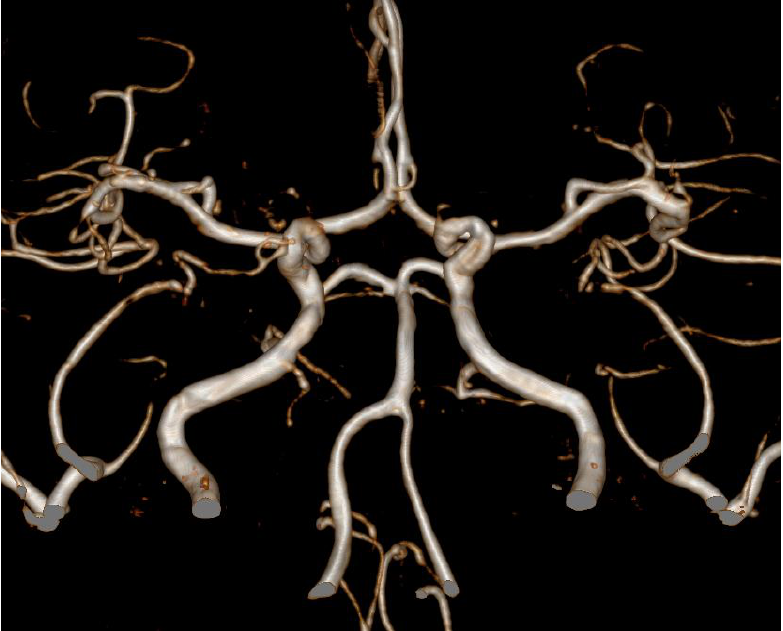
Figure 2. Magnetic resonance angiography (MRA). One year follow-up MRA revealed that multiple arterial stenosis was resolved.